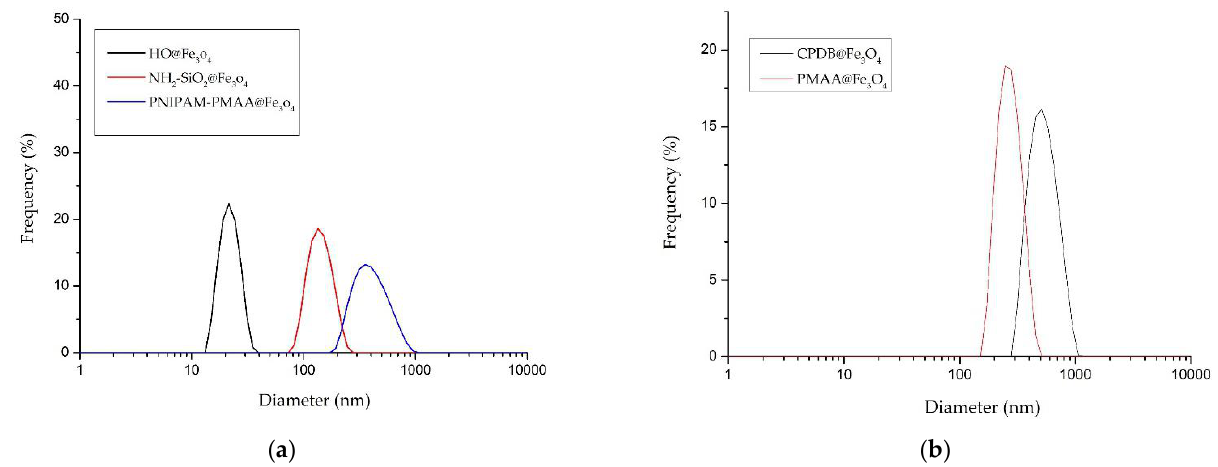
3 O 4 and ( b ) NH 2 -SiO 2 @Fe 3 O 4 .